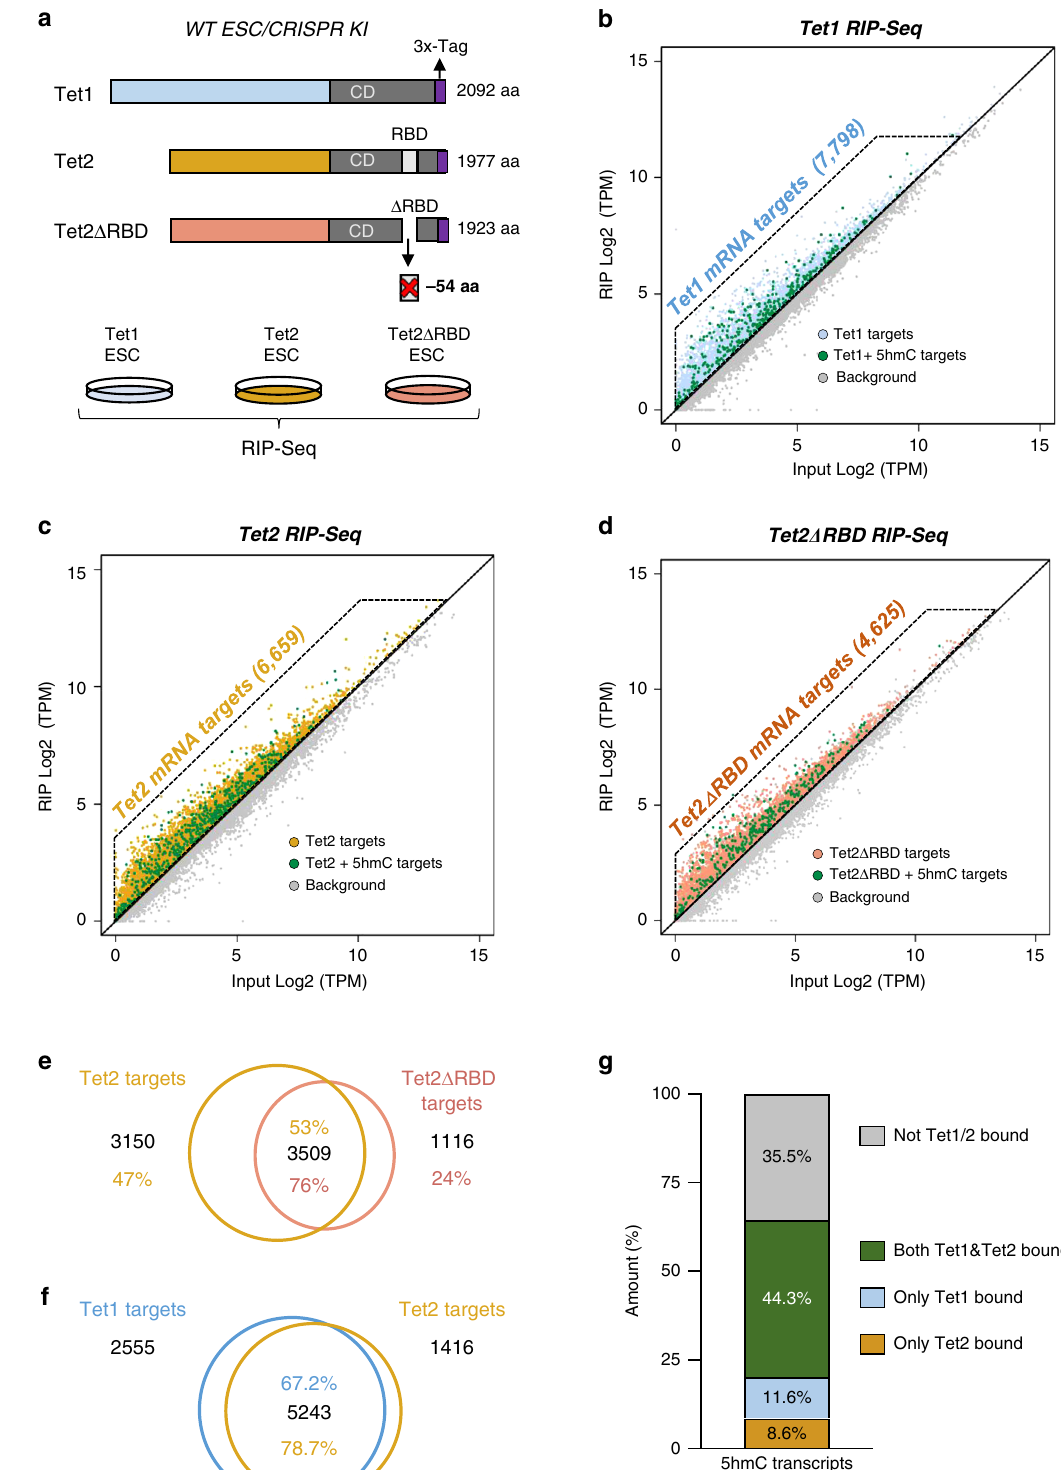
Fig. 3 Tet1 and Tet2 bind to speci fi c mRNAs within the transcriptome. a Diagram illustrating CRISPR-mediated tagging of endogenous Tet1, Tet2, and Tet2 Δ RBD proteins (CRISPR KI) and RIP-Seq experiment design. b Many mRNAs are bound by Tet1. Scatterplot showing the log-fold enrichment over input after Tet1-bound RNA immunoprecipitation. c RNA-binding targets of Tet2. Scatterplot showing the log-fold enrichment over input after Tet2-bound RNA immunoprecipitation. d Tet2 RBD is involved in mRNA targeting. Scatterplot showing the log-fold enrichment over input after Tet2 Δ RBD-bound RNA immunoprecipitation. e Tet2 binding to many RNAs depends on Tet2 RBD. Venn diagram showing the overlap between Tet2- and Tet2 Δ RBD-bound RNA targets identi fi ed by RIP-Seq. f Many common Tet1 and Tet2 targets. Venn diagram showing the overlap between Tet1- and Tet2-bound RNA targets identi fi ed by RIP-Seq. g 5hmC targets are often bound by both Tet1 and Tet2. Stacked bar chart showing the overlap between 5hmC-containing